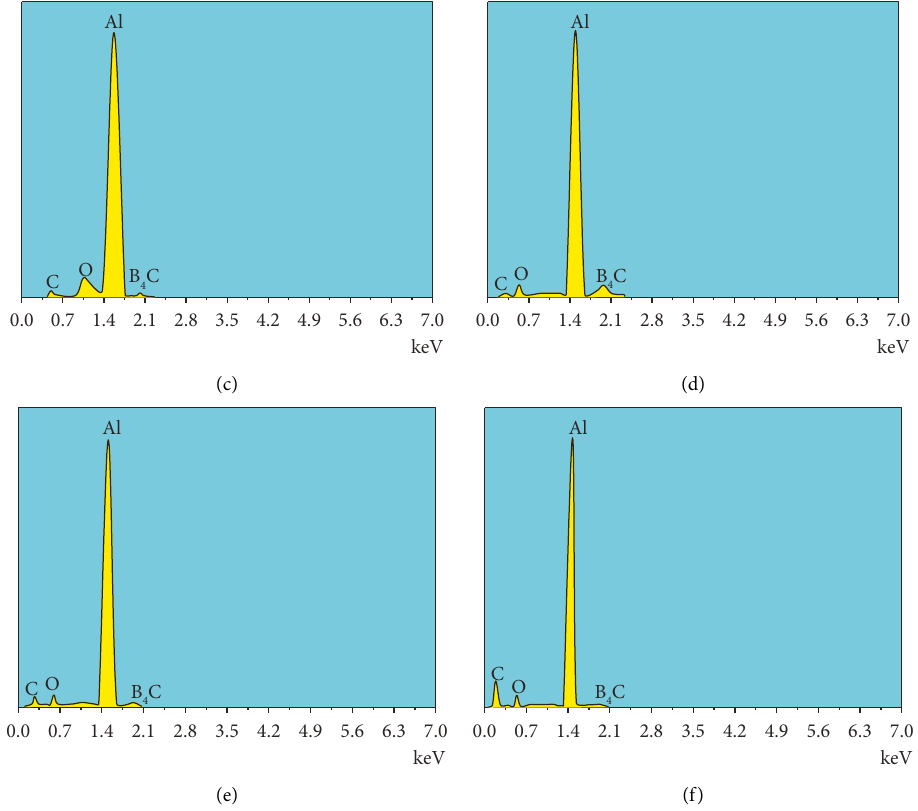
Figure 3: EDX of (a) Al 6061, (b) Al 6061+10% B 4 C, (c) Al 6061+10% B 4 C +1% CNT, (d) Al 6061+10% B 4 C +1.5% CNT, (e) Al 6061+10% B 4 C +2% CNT, and (f) Al 6061+10% B 4 C +2.5% CNT.